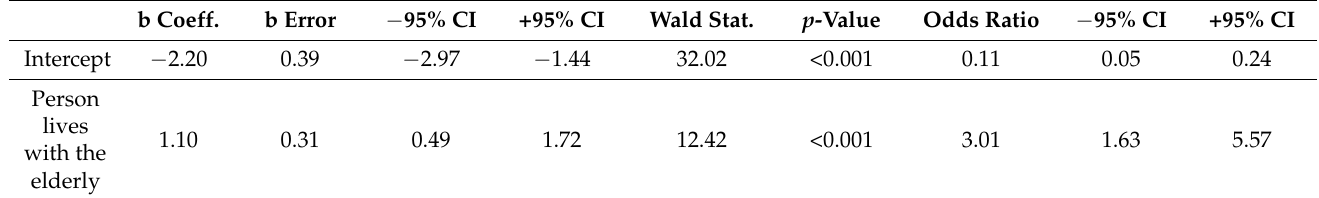
Table 6. Model of logistic regression analysis of the variables emotional fear reactions and person lives with the